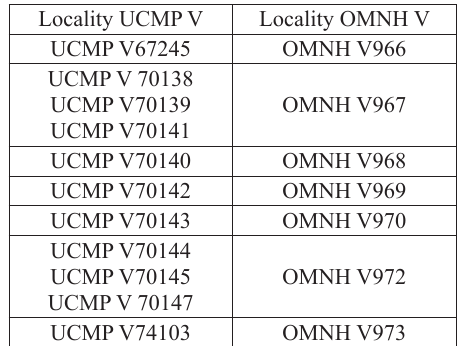
Table 1. Equivalency chart of the localities constituting the Eastgate LF that have been assigned UCMP V and OMNH V numbers. No OMNH locality numbers were created for the following UCMP localities: UCMP V74104, UCMP V87139, UCMP V88079, UCMP